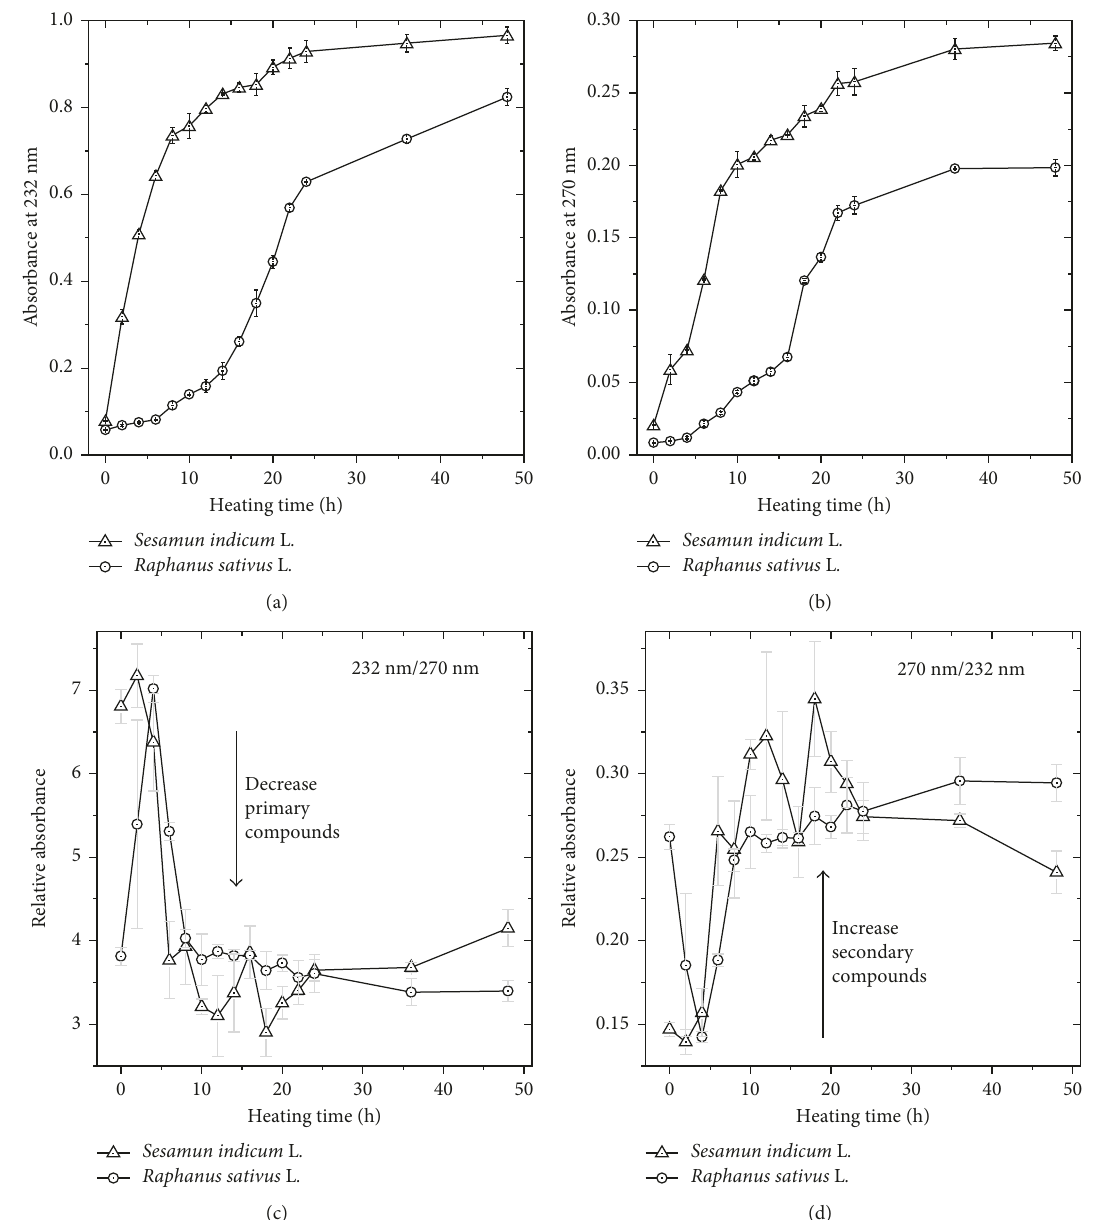
Figure 2: Absorbance values at (a) 232nm and (b) 270nm for biodiesels from S. indicum L. and R. sativus L. during the thermal degradation process. (c) and (d) show the absorbance ratios with formation of secondary compounds after ∼ 10h of thermal degradation. Error bars represent standard